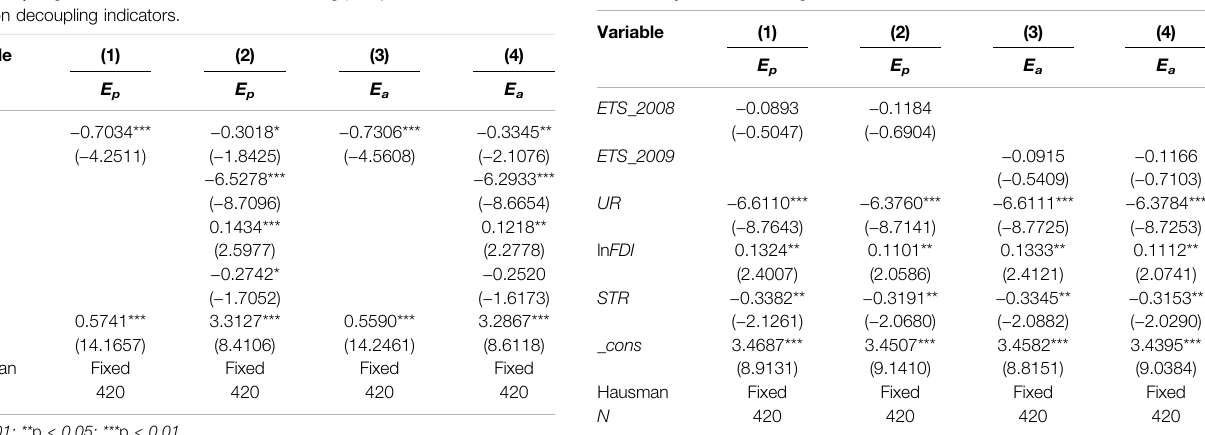
TABLE 3 | Placebo test regression results.